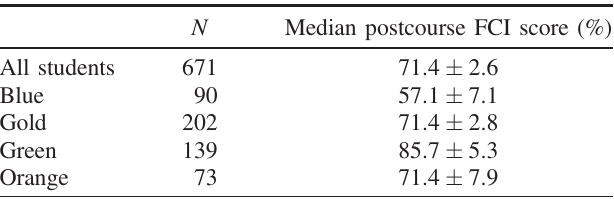
TABLE IX. Median postcourse FCI